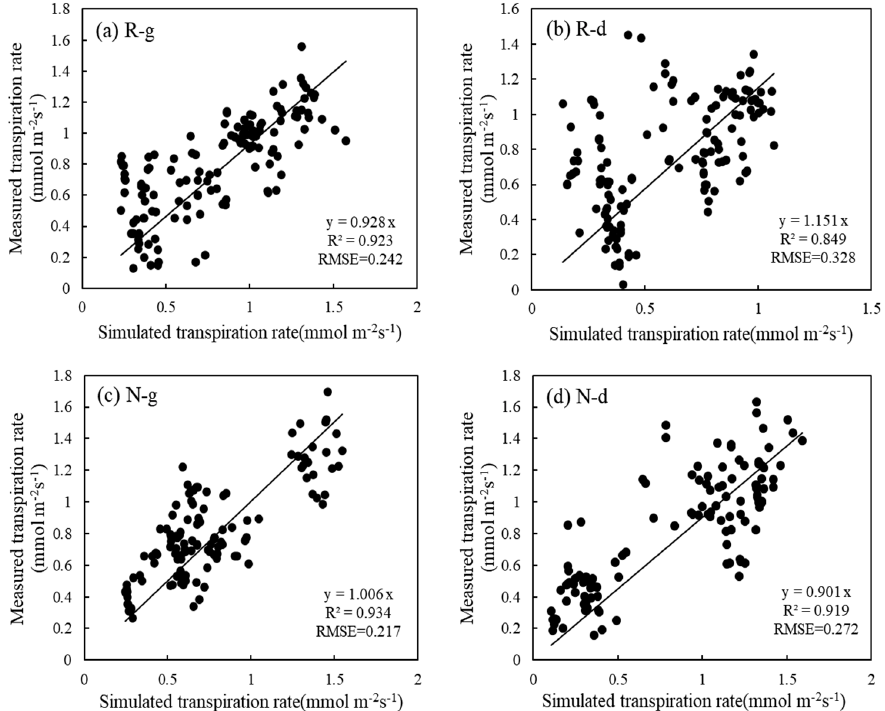
Figure 5. Fitting of measured and simulated transpiration rates among different treatments. ((a) R- g = warming of 1.5 °C with sufficient water supply, (b) R-d = warming of 1.5 °C with water deficit, (( a ) R-g = warming of 1.5 ◦ C with sufficient water supply, ( b ) R-d = warming of 1.5 ◦ C with wa- (c) N-g = non-warming with sufficient water supply, (d) N-d = non-warming with water deficit.). ter deficit, ( c ) N-g = non-warming with sufficient water supply, ( d ) N-d = non-warming with water